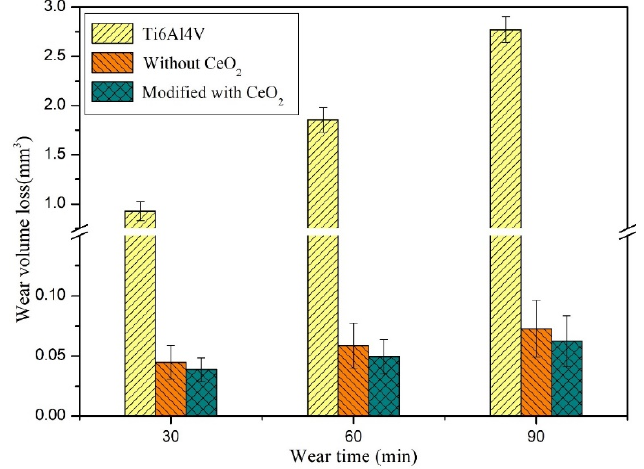
Figure 7. Microhardness distributions along the depth direction of the coatings without CeO 2 and the coatings modified with CeO 2 nanoparticles.